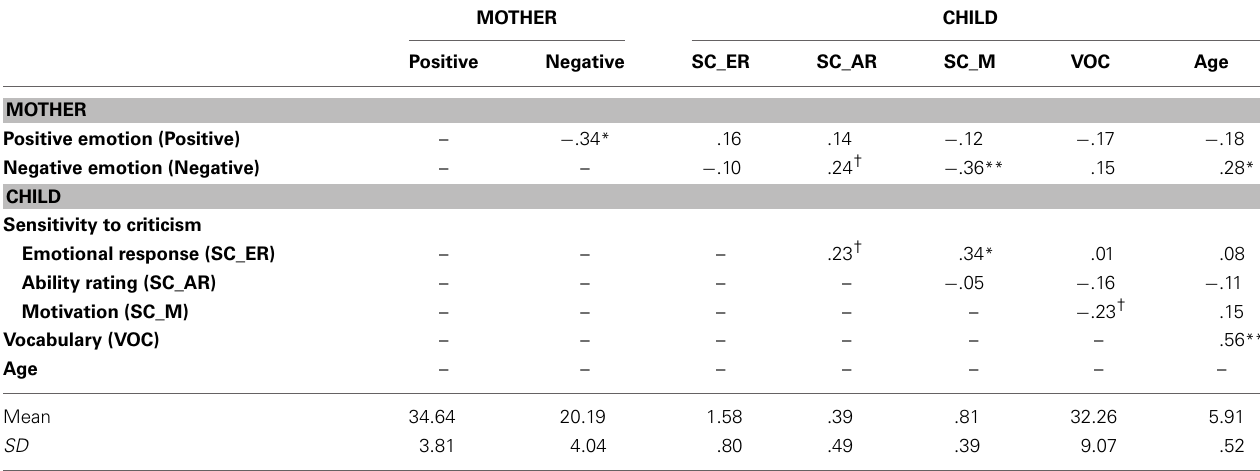
Table 1 | Mothers’ reported emotional expressiveness in mother–child interactions (positive and negative), children’s sensitivity to criticism (emotional response, rating of ability, and motivation), vocabulary scores, and age: descriptive statistics and